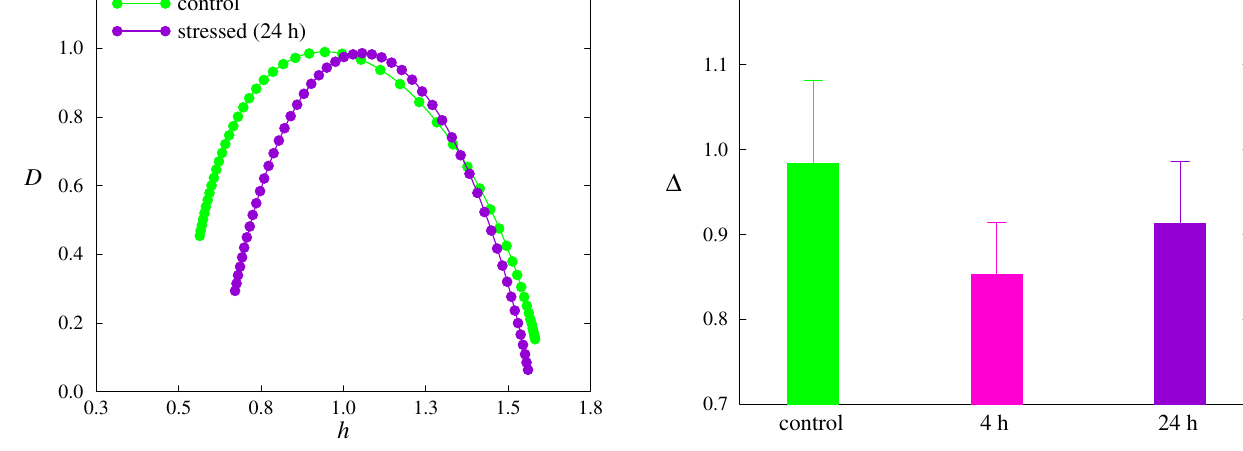
Fig. 7. Singularity spectra characterizing dynamics of CVBF in a healthy newborn rat and in a newborn rat with the stress- induced ICH.